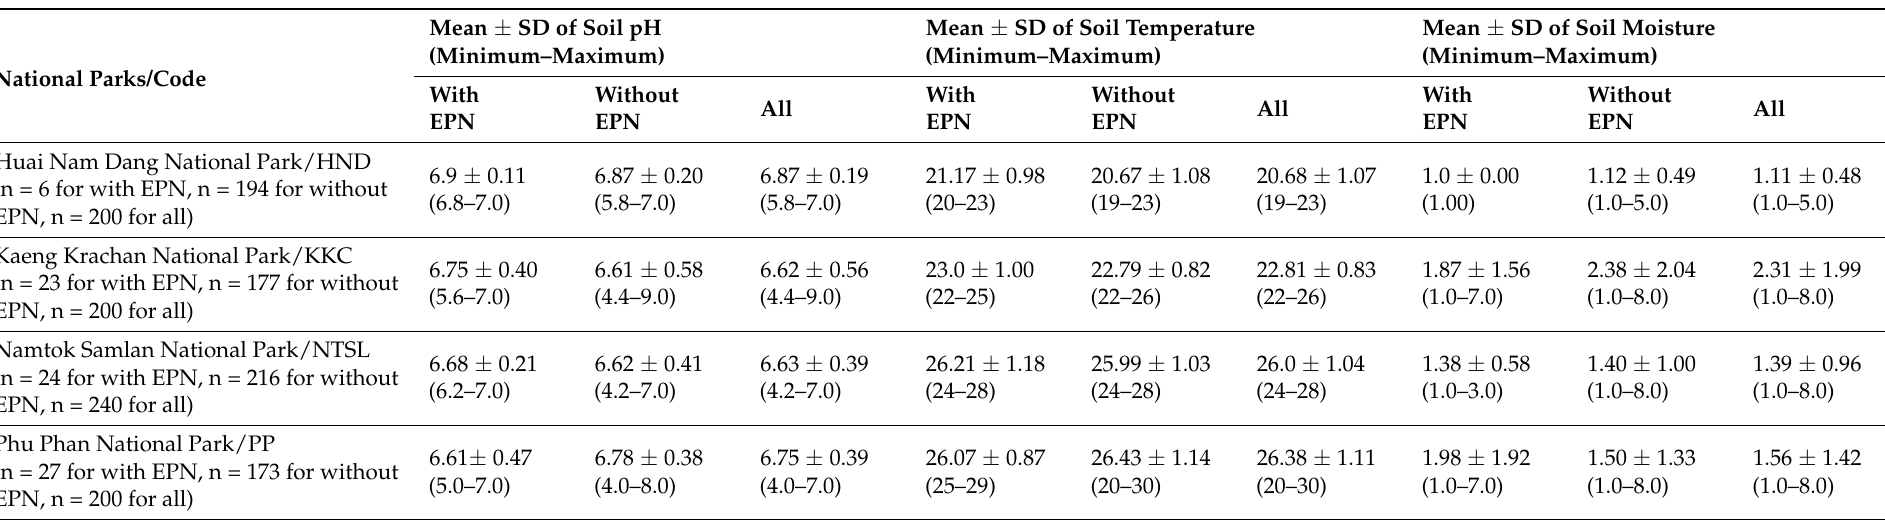
Table 2. Soil pH, temperature and moisture of the samples collected from 4 of Thailand’s national